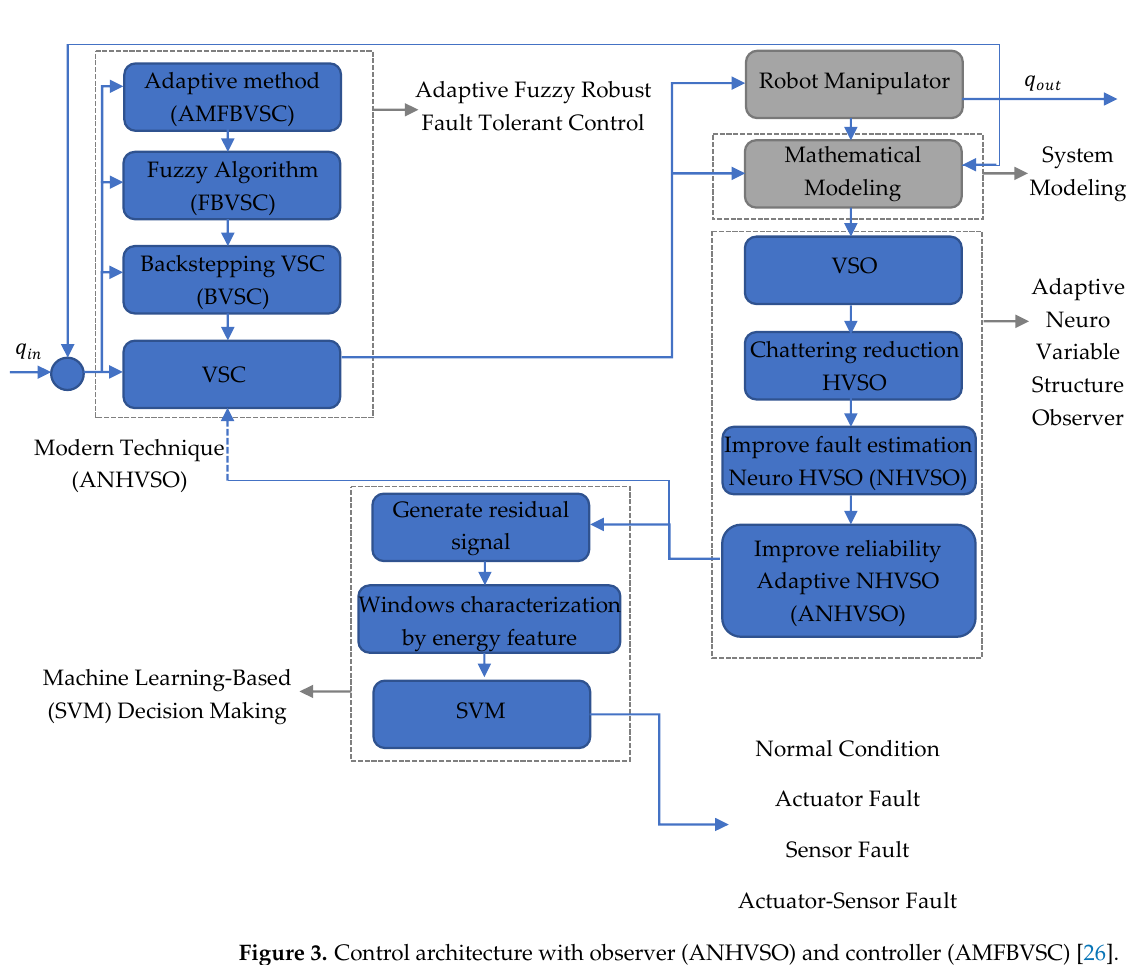
Figure 3. Control architecture with observer (ANHVSO) and controller (AMFBVSC) [26].